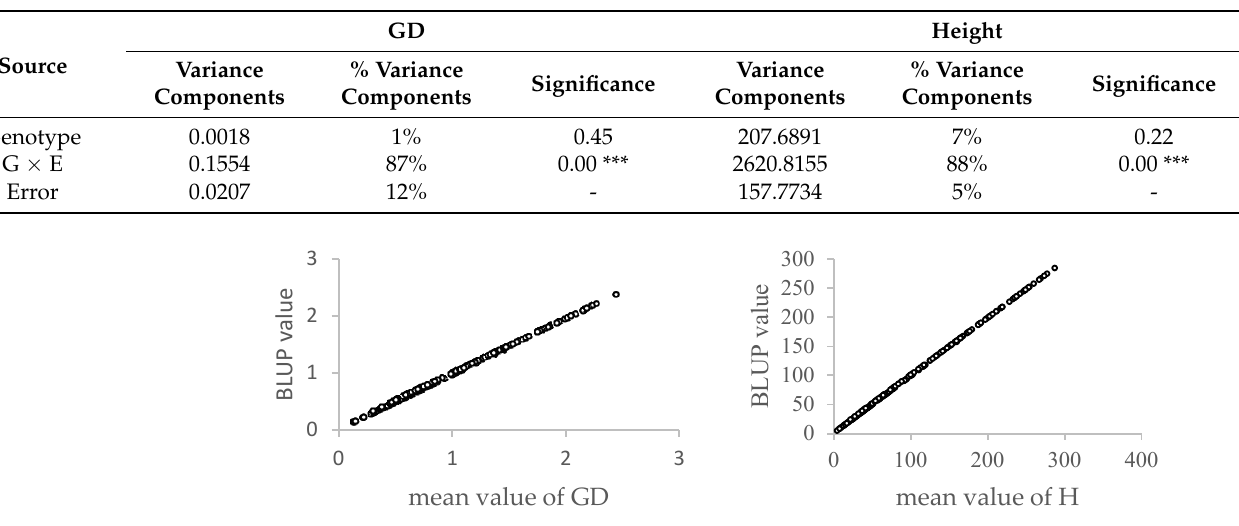
Figure 1. Comparison of the observed and linear unbiased prediction (BLUP) values. The BLUP value has an obvious correlation with the observed value and can reflect the real growth status.